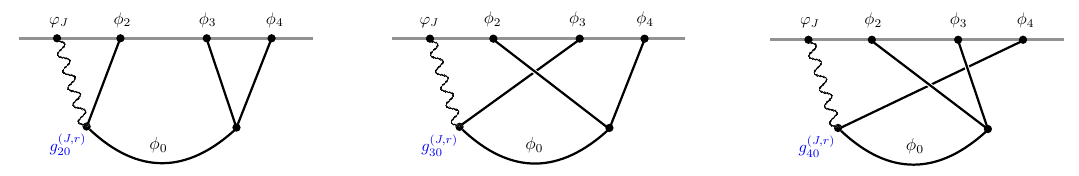
Figure 2 . s -, t - and u -channel exchange of a scalar φ 0 between scalars φ 2 , 3 , 4 and a single partially- massless spin- J field of depth- r in de Sitter